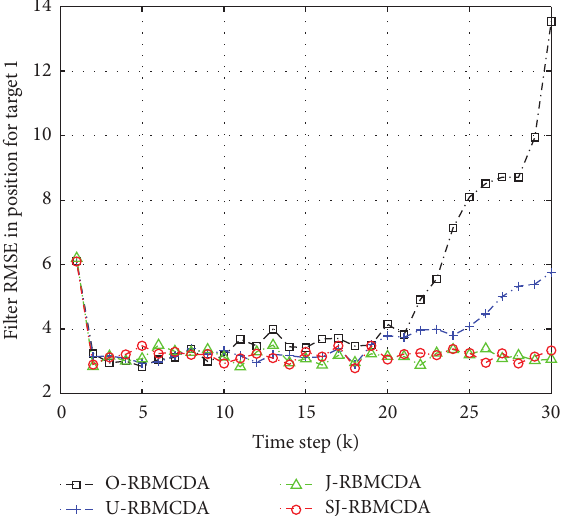
Figure 9: Example of tracking three crossing